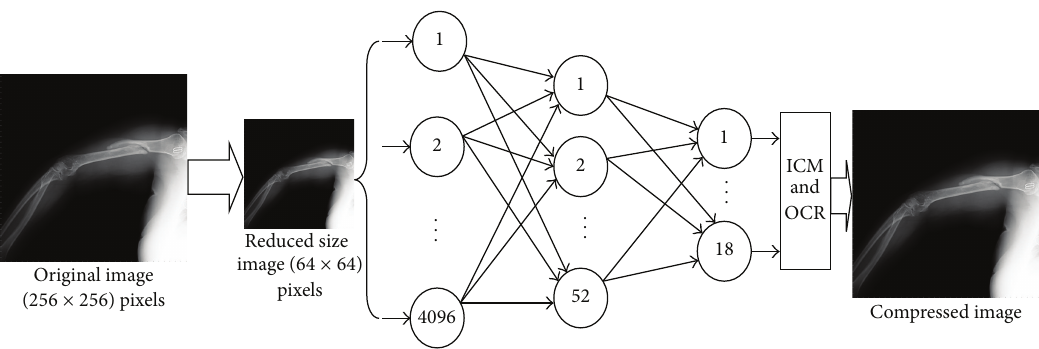
Figure 4: X-ray image compression system. ICM: ideal compression method, OCR: optimum compression ratio.